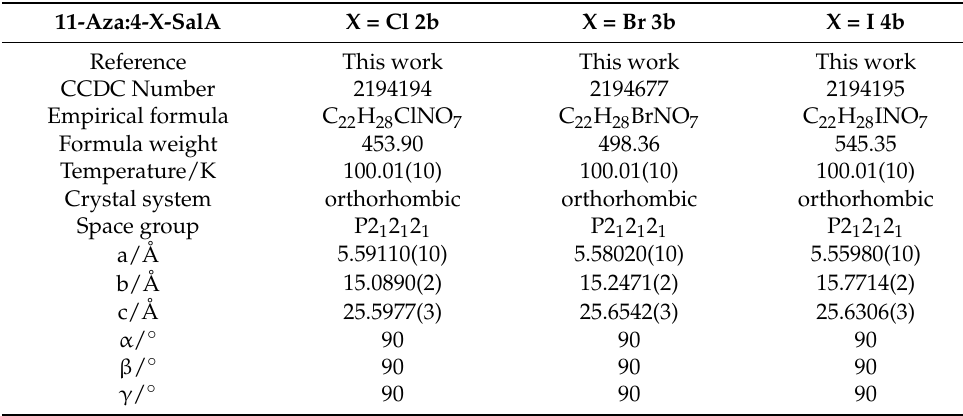
Table 2. Crystal Data Summaries for 2b , 3b and 4b , orthorhombic polymorph